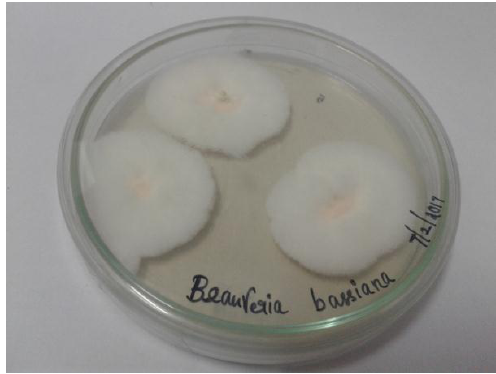
Figure 1. Seven days old strains of B. bassiana -28 .